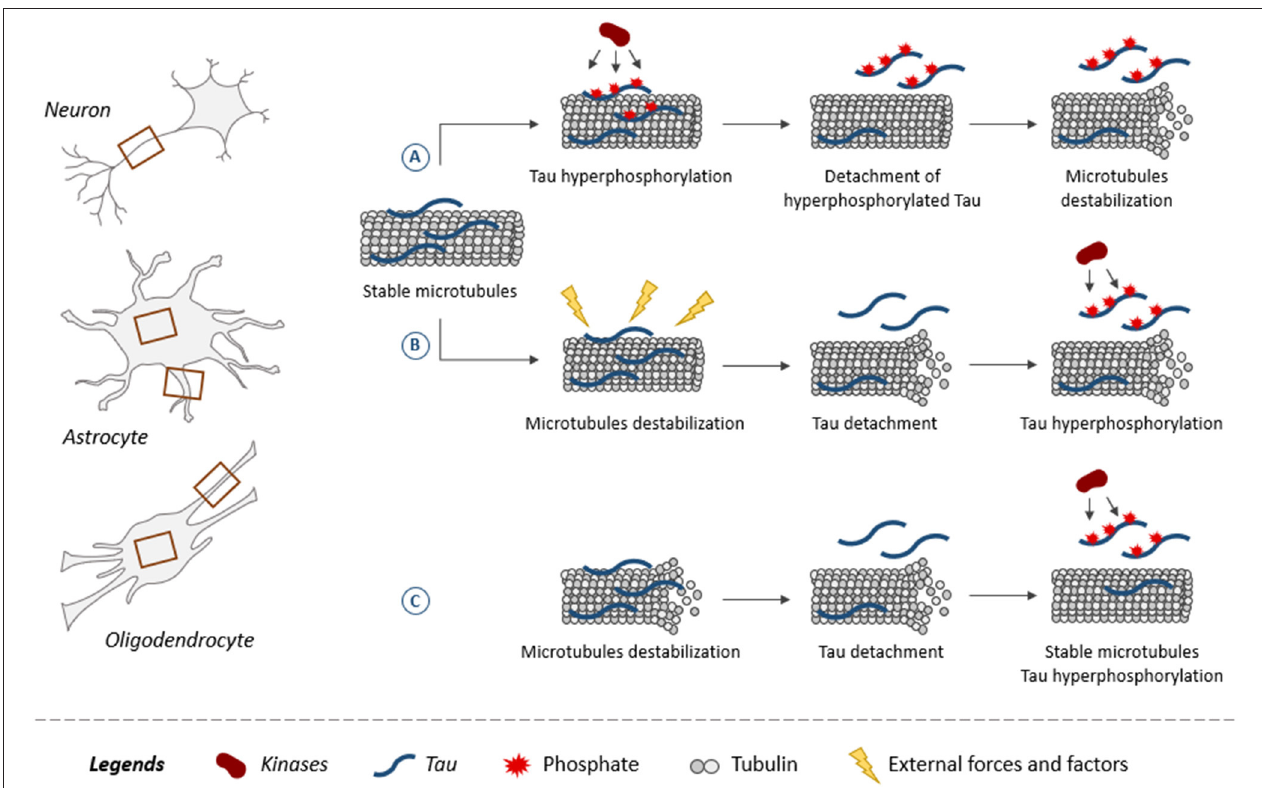
FIGURE 3 | Role of tau and its phosphorylation in microtubule dynamics. Microtubules, composed of tubulin, are found in both neuronal and glial processes (astrocytes and oligodendrocytes) as indicated by brown squares. Illustration of three scenarios on how tau plays a role in microtubule dynamics within neurons and glial cells. Tau promotes assembly and stabilization of microtubules (A,B) . (A) When tau becomes hyperphosphorylated, it reduces its binding to microtubules resulting in its detachment. Microtubules are destabilized upon the loss of tau at their surface. (B) External forces and factors destabilize microtubules, leading to the detachment of tau increasing its access to kinases, which results in its hyperphosphorylation. (C) Tau binding does not stabilize microtubules but instead increases their dynamics. The detachment of tau from microtubules and its hyperphosphorylation is associated with an increase of microtubule